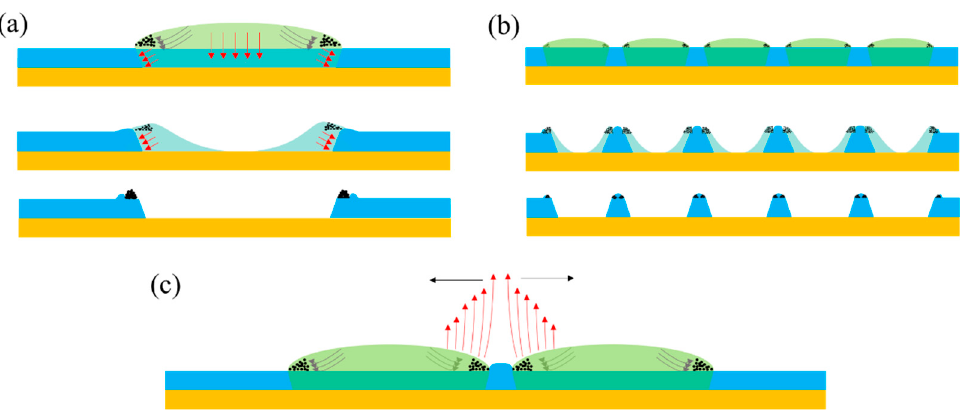
Figure 7. The dynamic formation process of obtained microstructure: ( a ) a single dot, ( b ) a dots array, and ( c ) a repulsive force model to prevent adjacent droplets from